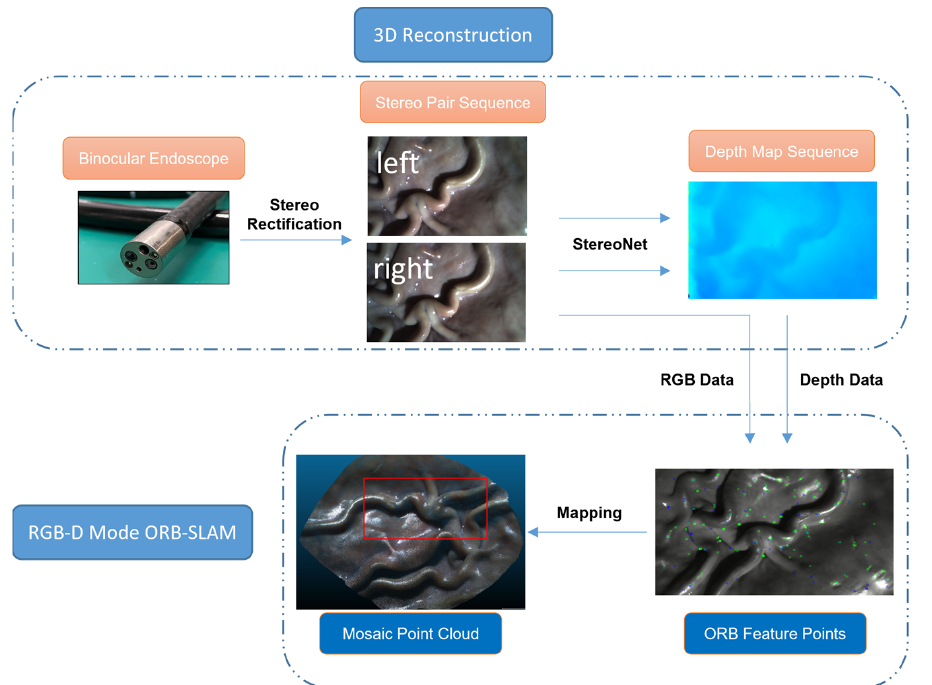
Figure 1. Framework of our method.